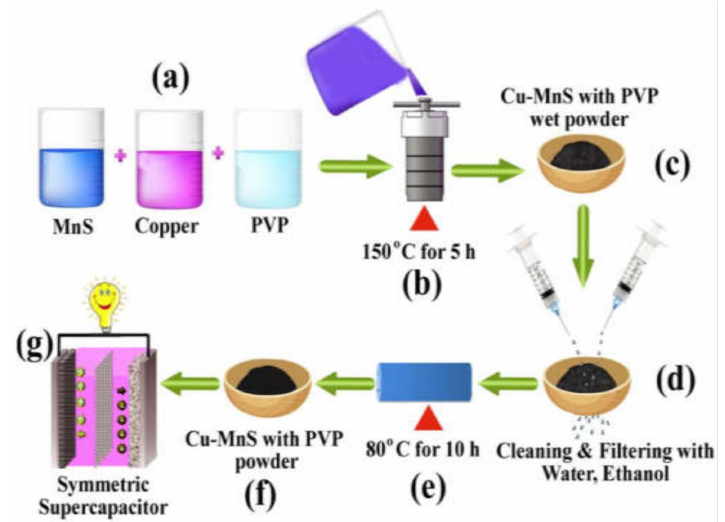
Figure 7. Hydrothermal synthesis process for Cu-MnS with a PVP nanocomposite for a high- performance supercapacitor. Reproduced with permission from [143]. Energies, 2018.